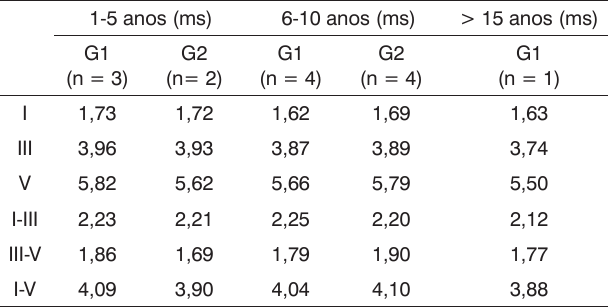
Tabela 5. Comparação das médias das latências absolutas e dos intervalos interpicos dos PEATE para G1 e G2, segundo o tempo de uso de drogas.